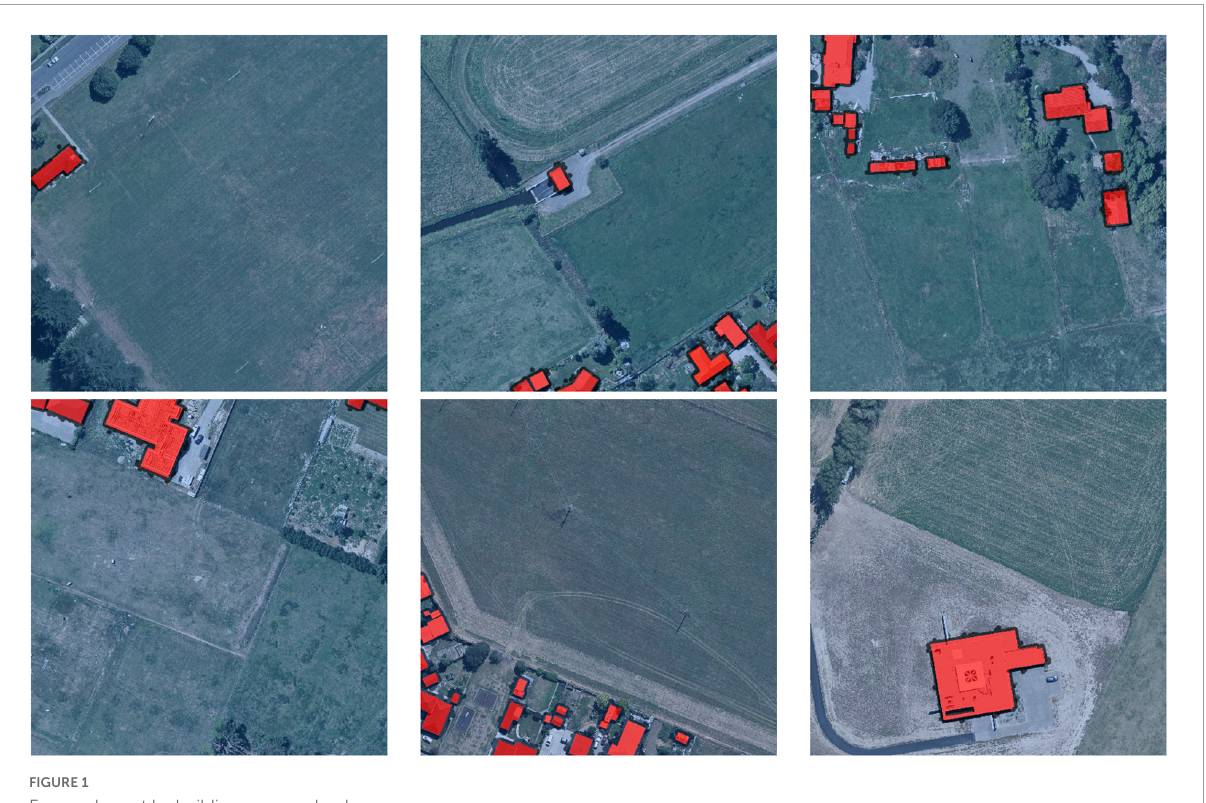
FIGURE1 Encroachment by buildings on